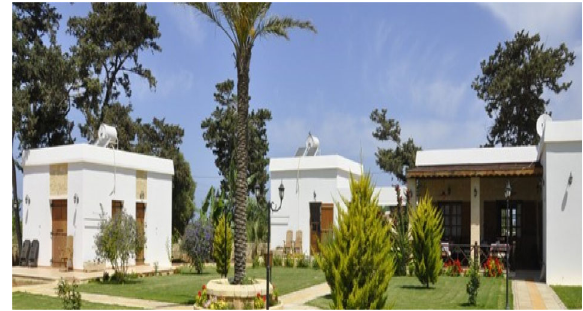
Fig. 9 Villa Lembos Hotel — Risokarpaso. Example of a piecewise